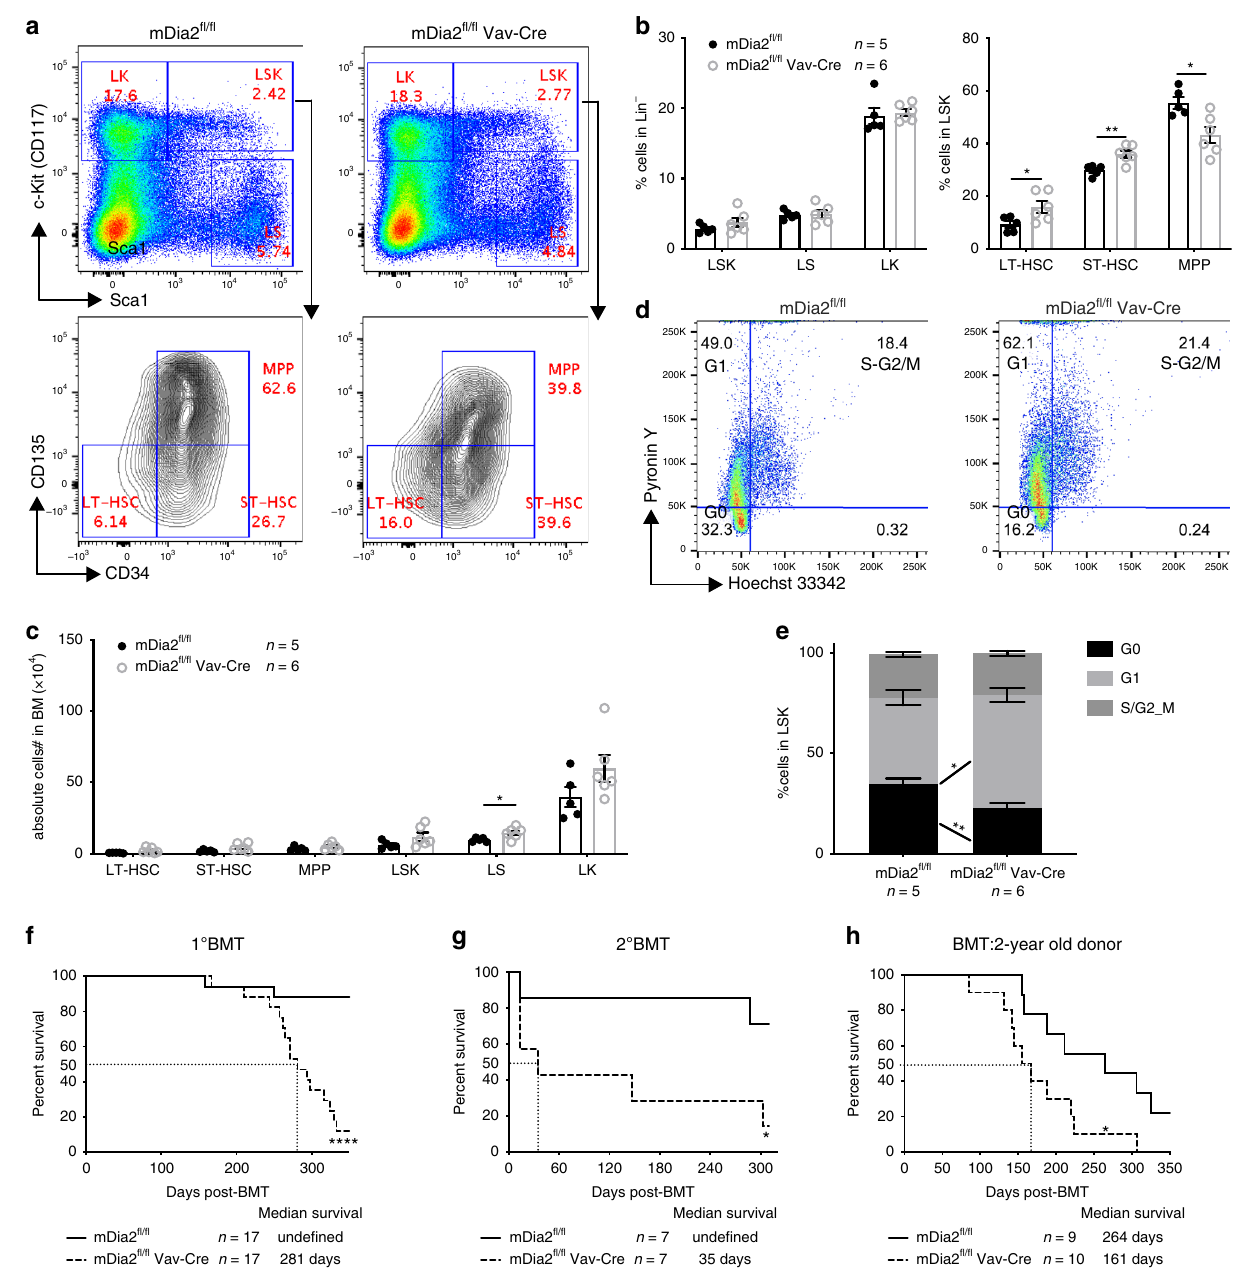
Fig. 1 mDia2 is required for HSPC engraftment in bone marrow transplantation. a Representative fl ow cytometric plots showing gating of different HSPC subpopulations in bone marrow lineage negative cells from wild type mice 4 months after transplantation with 2× 10 6 BMMCs from control or mDia2 fl / fl Vav-Cre mice. b The percentages of indicated HSPC subpopulations in a . c The absolute number of indicated HSPCs in a . d Representative fl ow cytometric plots of cell cycle pro fi le of LSK cells in a . e Quantitative analyses of d . n = 5 mice in mDia2 fl / fl , n = 6 in mDia2 fl / fl Vav-Cre for both b , c , and e . f Kaplan – Meier survival curve of mice transplanted with 2× 10 6 BMMCs from control or mDia2 fl / fl Vav-Cre mice. n = 17 mice in each group. g Kaplan – Meier survival curve of mice transplanted with 2 × 10 6 BMMCs from primary transplanted mice in e . n = 7 mice in each group. h Kaplan – Meier survival curve of wild type mice transplanted with 2× 10 6 BMMCs from 2 years old control or mDia2 fl / fl Vav-Cre mice. n = 9 mice in mDia2 fl / fl group, n = 10 in mDia2 fl / fl Vav-Cre group. All the error bars represent the SEM of the mean. * p < 0.05, ** p < 0.01, *** p < 0.001, **** p < 0.0001. Two-tailed unpaired Student ’ s t test was used to generate the p values. Signi fi cance for survival analyses in f – h was calculated by log-rank (Mantel – Cox) (Fig. 1g), indicating an important role for mDia2 in long-term To further investigate the role of mDia2 under BMT stress HSC maintenance. We also performed a BMT assay using donor conditions, we performed a competitive BMT (cBMT) assay in BMMCs from aged (>2 year) mDia2-de fi cient mice. The recipient which an equal number of BMMCs from CD45.2 + mDia2 fl / fl Vav-Cre mice and CD45.1 + congenic WT mice were trans- mice showed signi fi cantly increased lethality compared to those transplanted with cells from wild type counterparts (Fig. 1h). planted into lethally irradiated wild type CD45.1 + recipient mice Taken together, these data demonstrate important functions of (Fig. 2a). Testing of peripheral blood chimerism 5 weeks after mDia2 in maintaining HSPC integrity in BMT. transplantation revealed that the absence of mDia2 elicited an